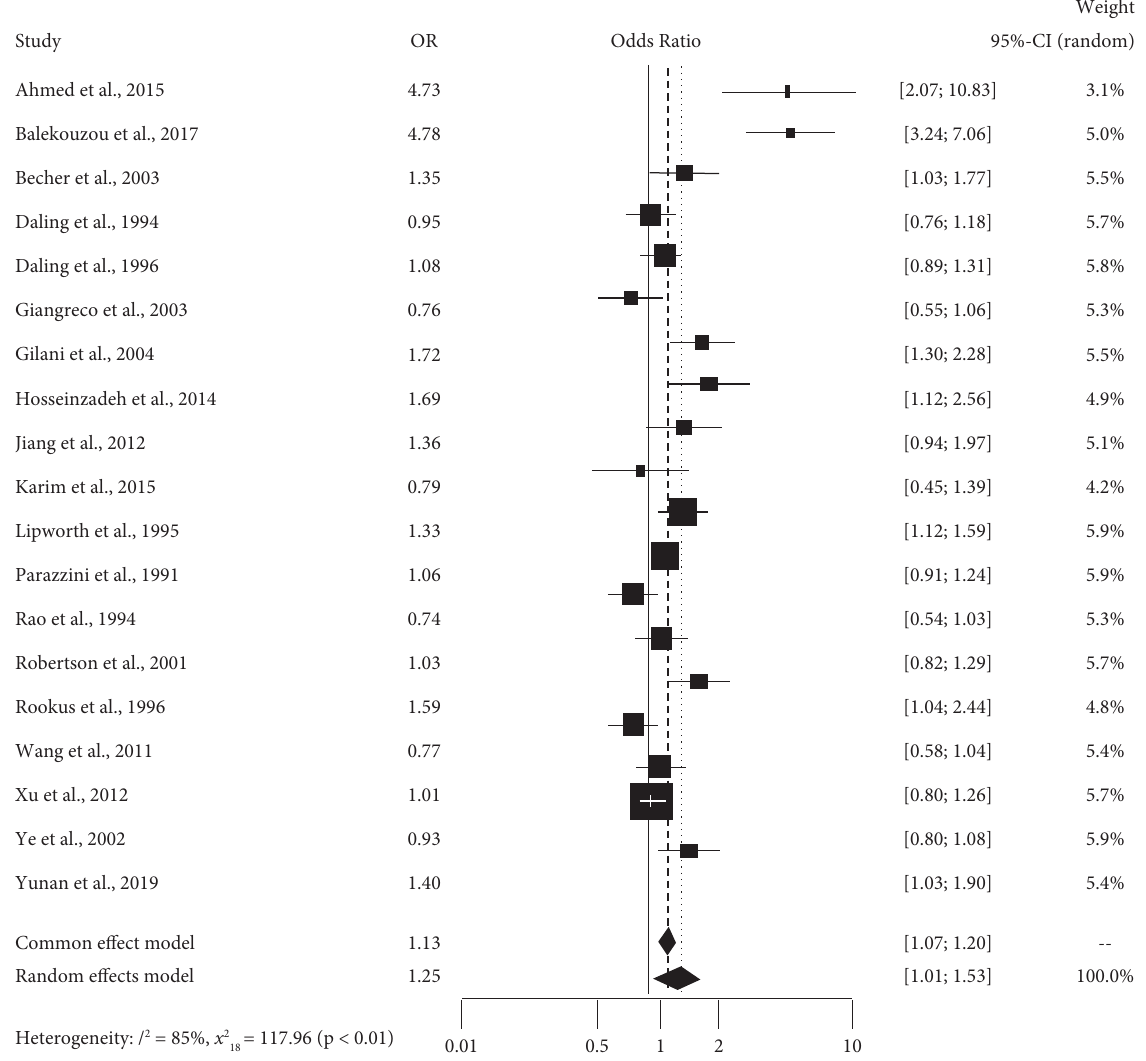
Figure 3: Forest plot showing the induced abortion case on breast cancer. Table 5: Summary of the subgroup for abortion case and smoking random efects analysis and fxed efects model for abortion. Developing Variables